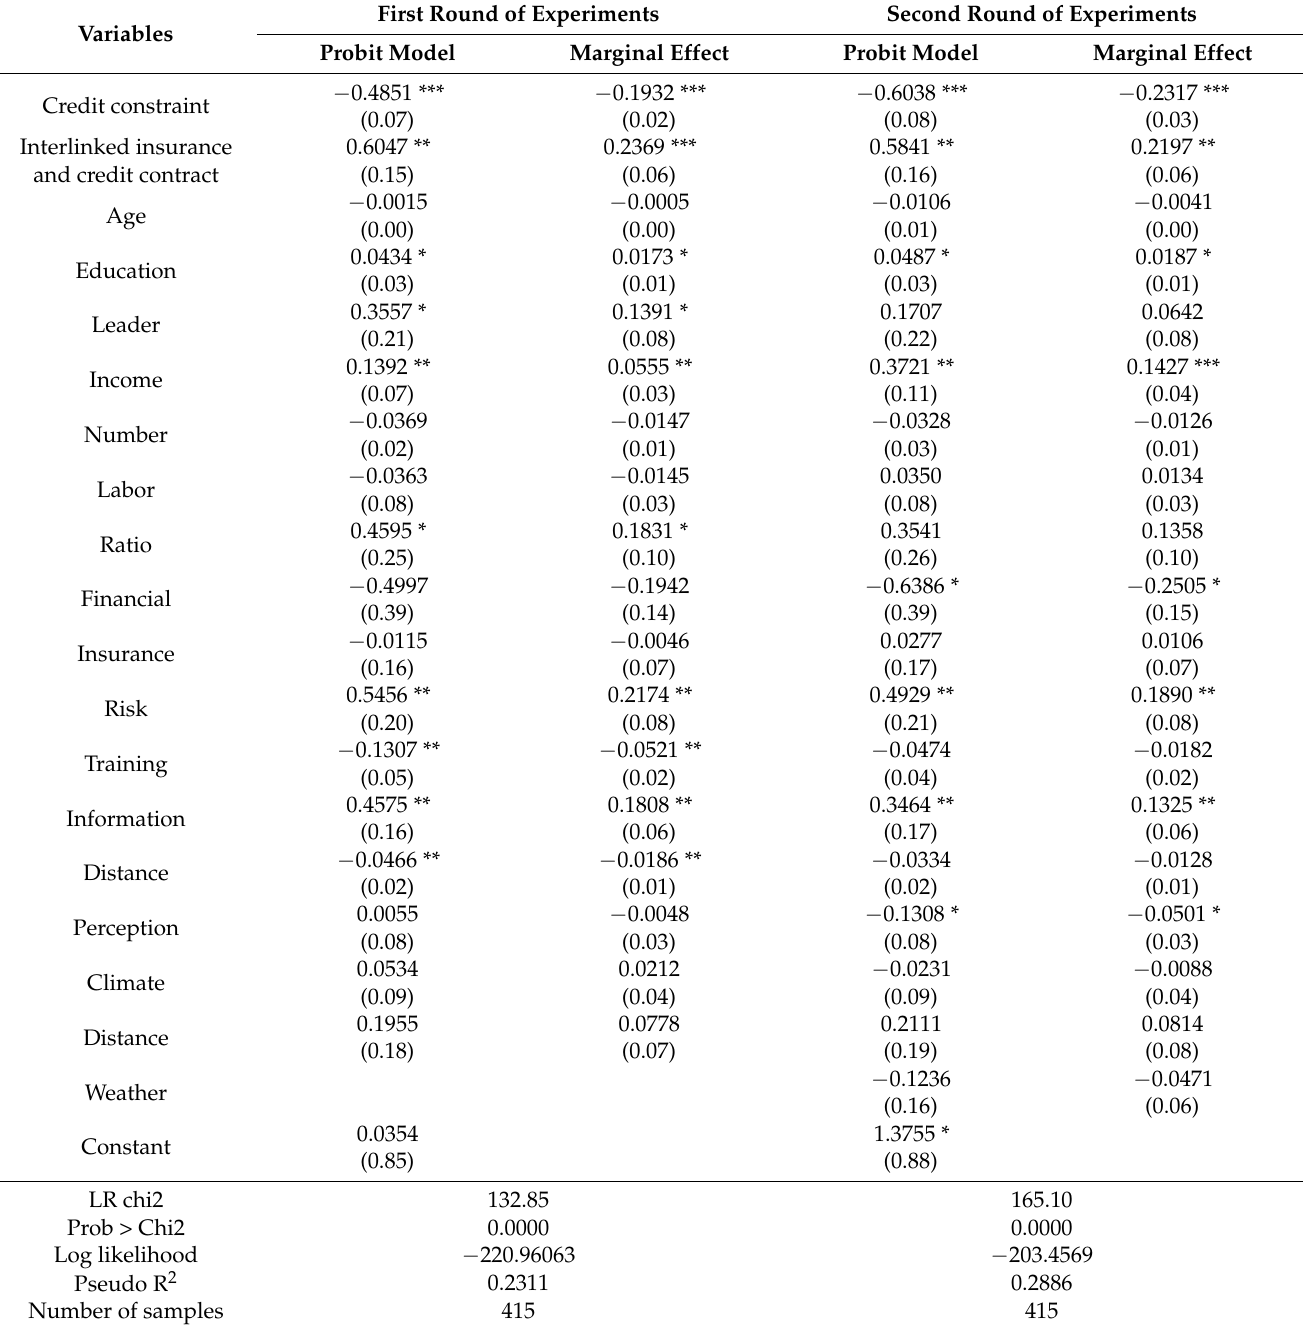
Table 6. Regression results of probit model for two rounds of